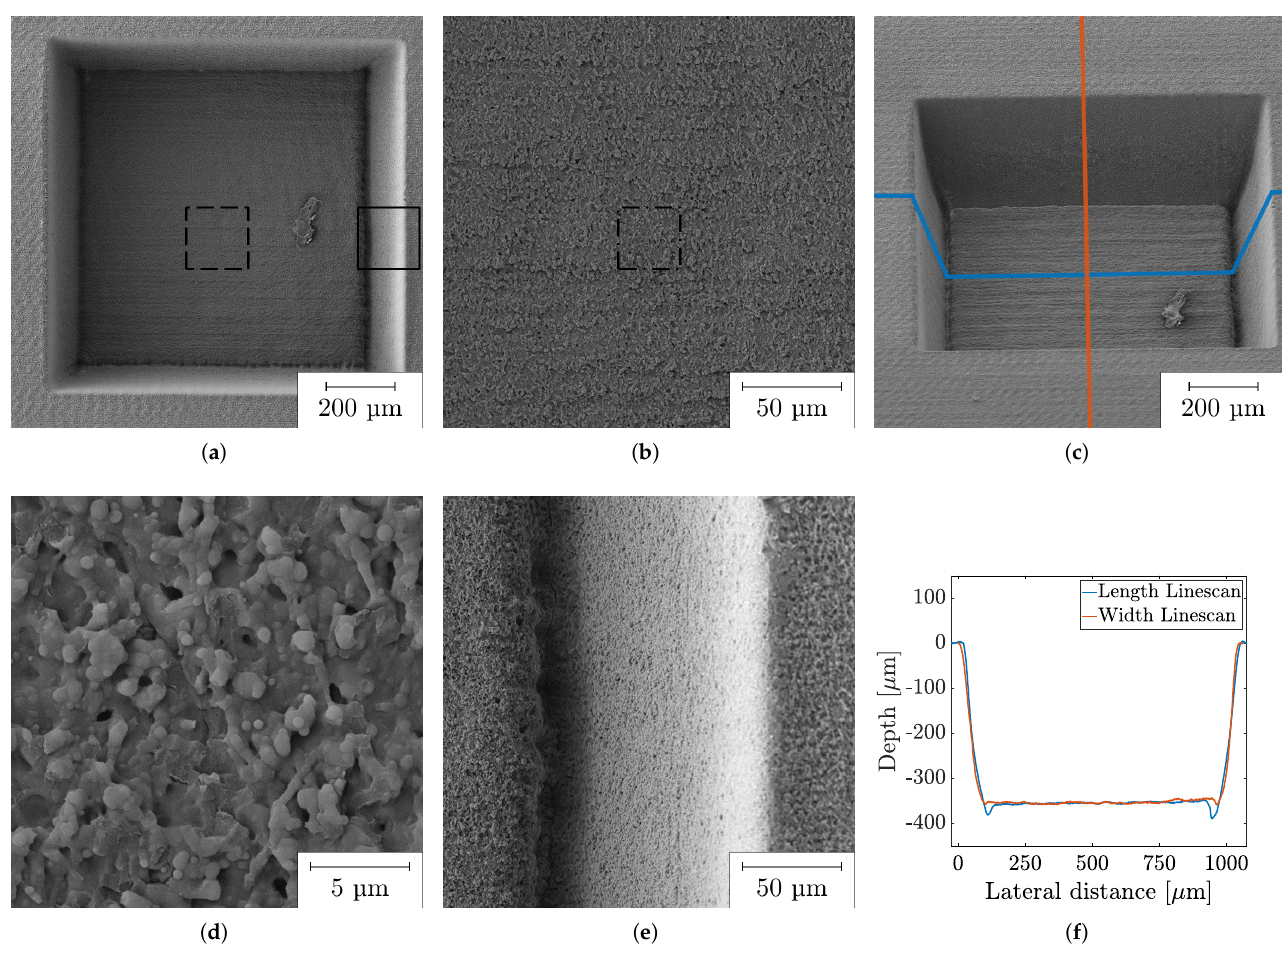
Figure 5. SEM images of an ablation cavity on COC with a fluence of 10.5Jcm − 2 in different magnifi- cations: ( a ) overview; ( b ) magnified section of ( a ) (dashed line); ( c ) tilted image; ( d ) magnified section of ( b ); ( e ) magnified section of ( a ) (solid line) with trough; ( f ) line scans in X and Y direction of ( c